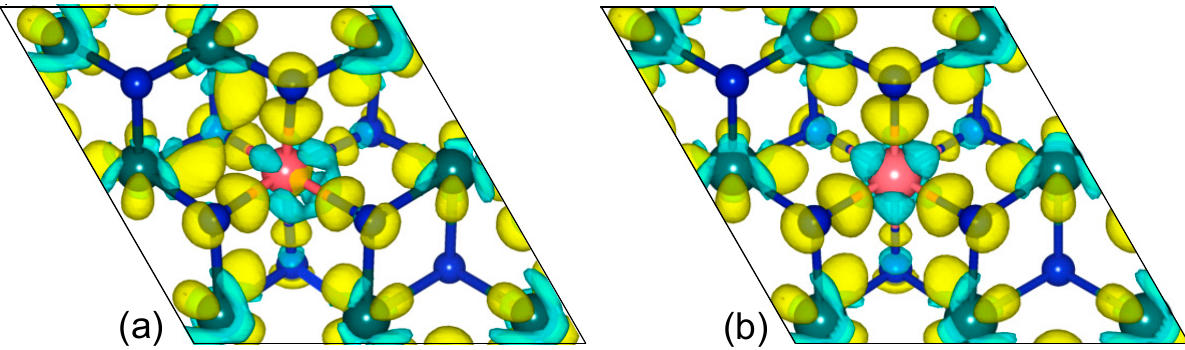
Figure 2. Charge density difference isosurfaces for ( a ) Mn-MoN(2 a ) and ( b ) Mn-MoN(6 c ). The pink, green, and blue balls denote the Mn, Mo, and N atoms, respectively.